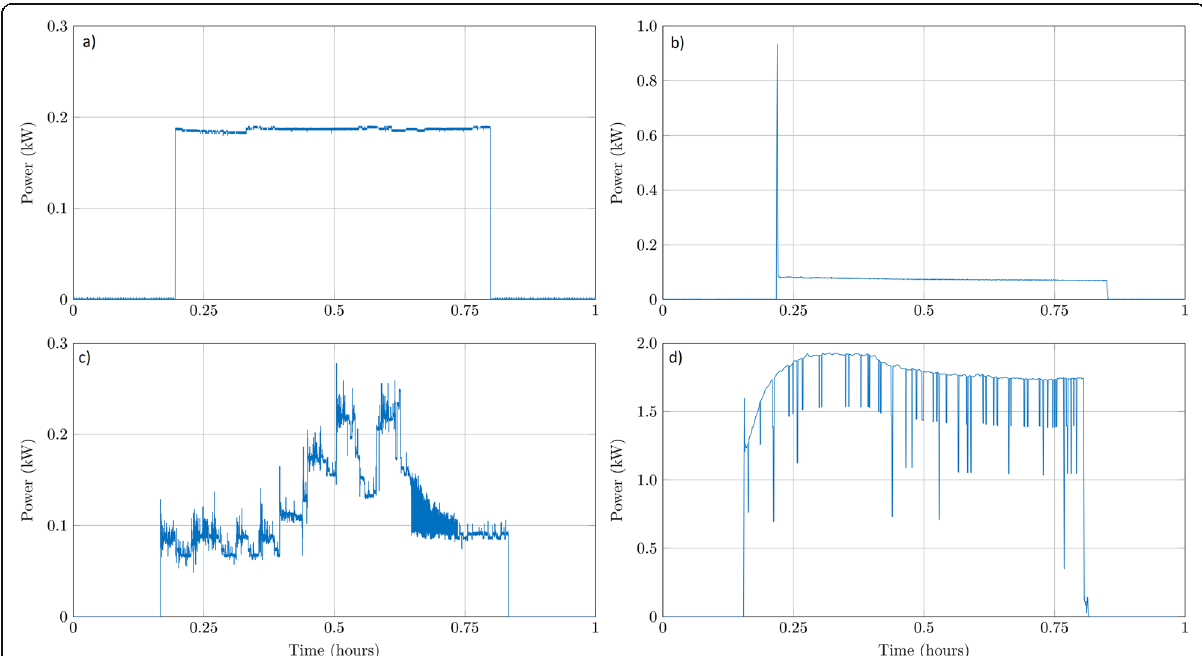
Fig. 3 Different appliance signatures for the four appliance types: ( a ) one-state without significant peak (lamp), ( b ) one-state appliance